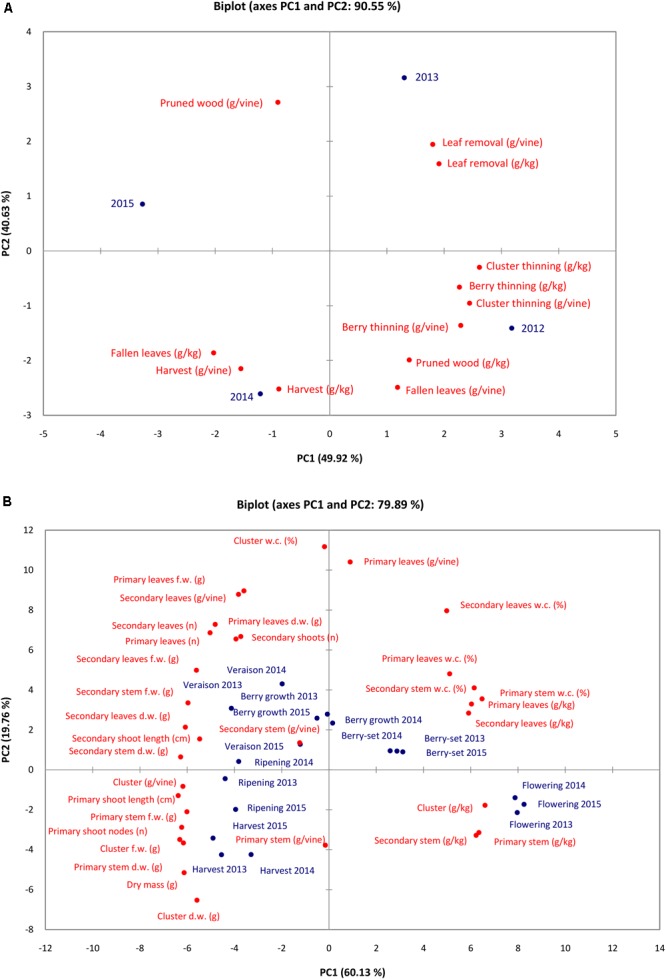
Principal component analysis plot of N content/concentration in materials removed with viticultural practices and fallen leaves in the different seasons (A) and the vine vegetative parameters and N content/concentration of vine organs at the different phenological growth stages and years (B).